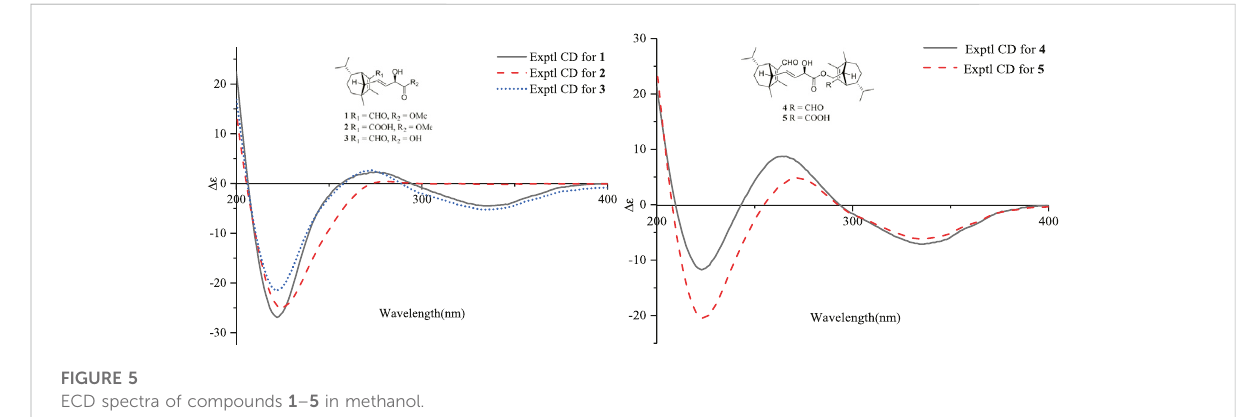
FIGURE 5 ECD spectra of compounds 1 – 5 in